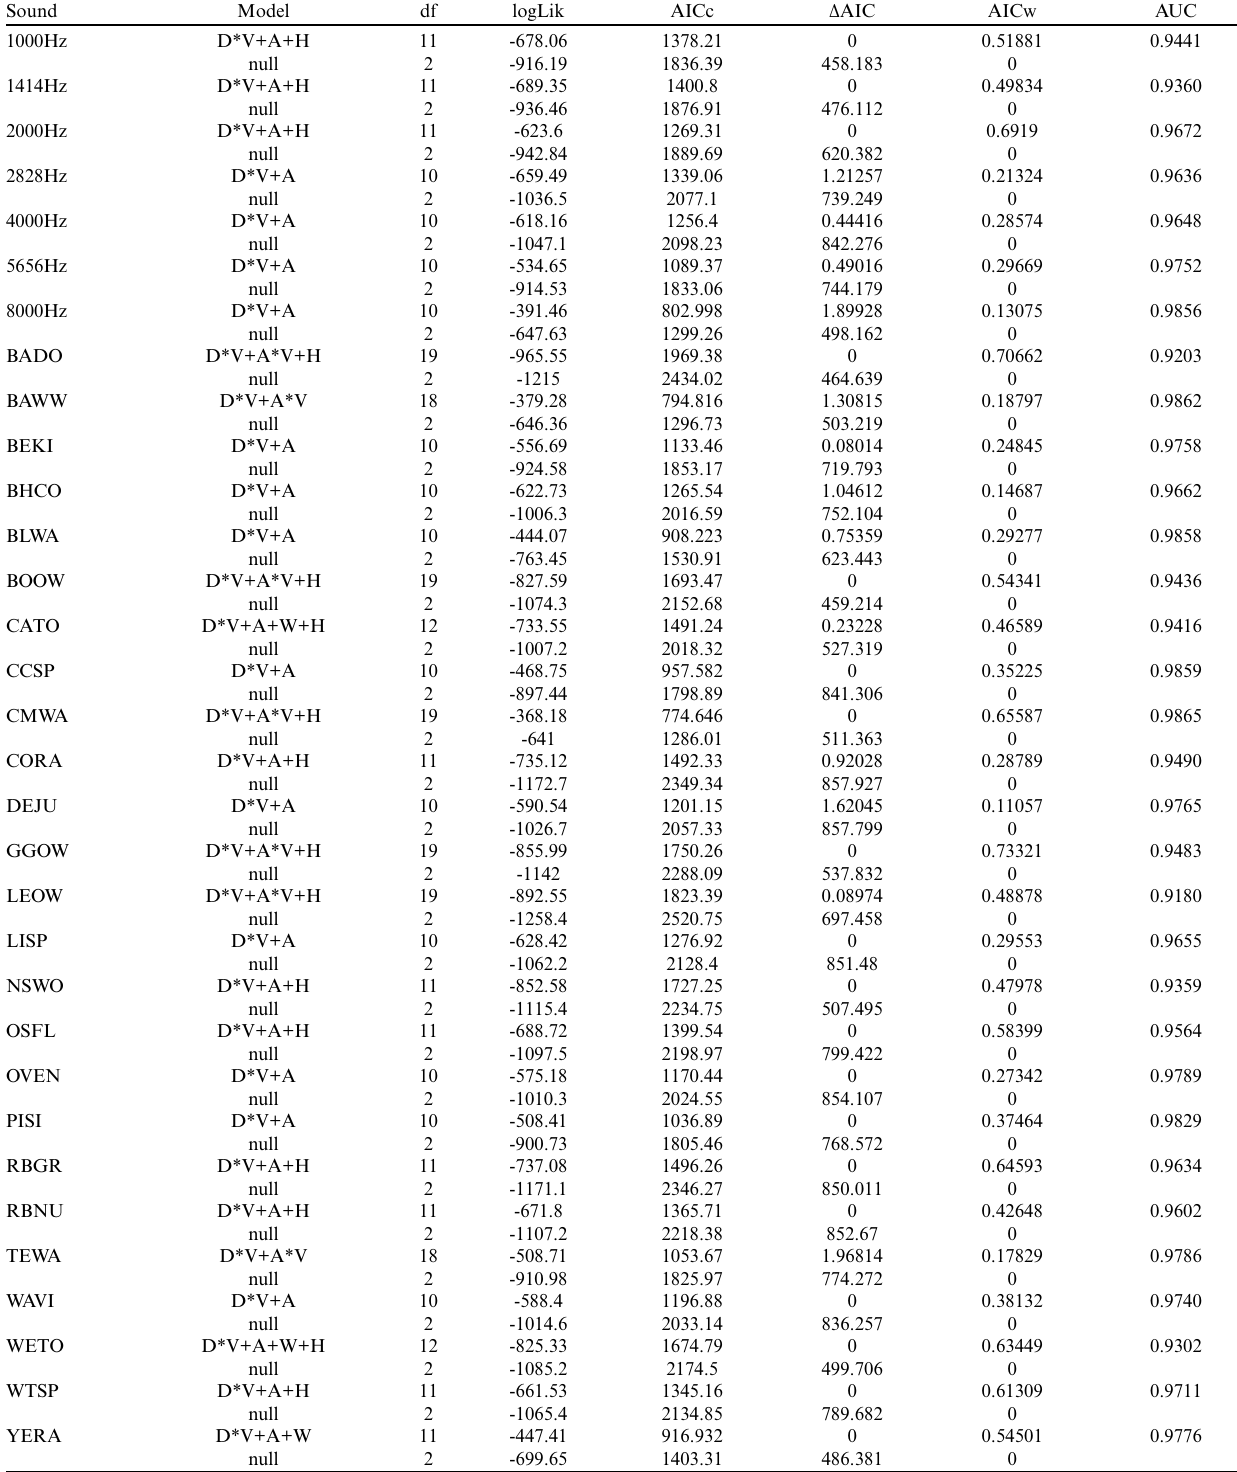
Table 5 . Model selection for factors influencing detection probability of different sounds for the ARU experiment and AUC statistics on test data for the top AIC-ranked model testing differences in detection distance between multiple models of ARU. All sounds used the same models for selection. We selected top models using lowest AICc value and ∆AICc. For multiple models with ∆AICc < 2, we selected the simplest model with fewest parameters (Arnold 2010). “df” is the degrees of freedom and “logLik” is the log likelihood value for that particular model. “*” indicates variable